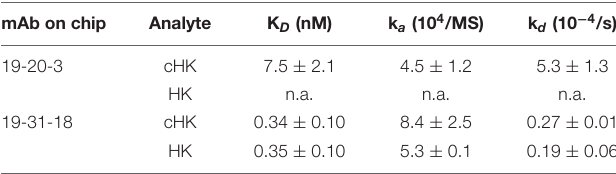
TABLE 1 | Binding parameters of the interaction between immobilized monoclonal antibody (mAb) 19-20-3 and 19-31-18 (0.012 pmol/mm 2 ) and H-kininogen (HK) or cleaved HK (cHK).